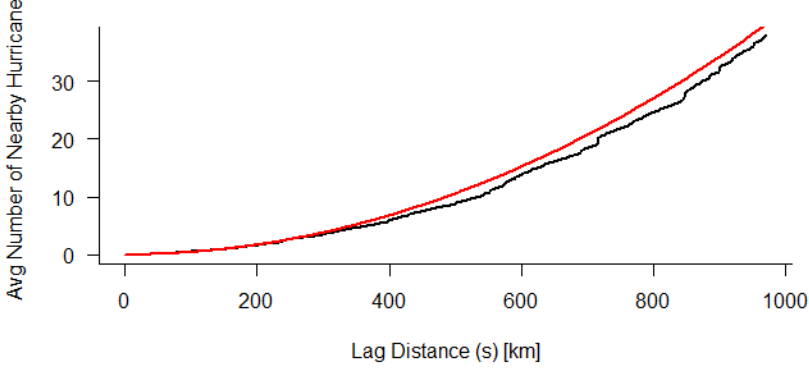
Figure 17. Generalization of K graph for inhomogeneous data of RI LMI points with the empirical (black) curve above the theoretical (red) curve to a lag distance of 350 km, indicating significant clustering up to this point of distance between hurricanes.